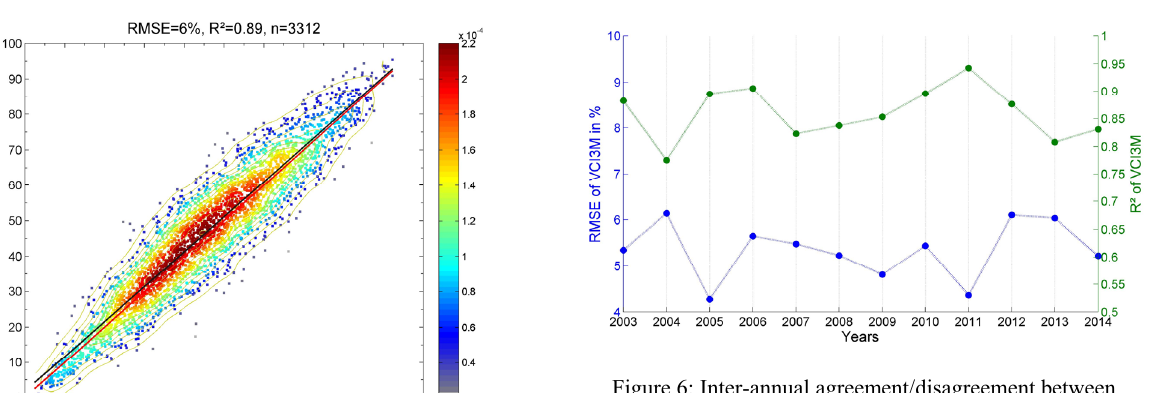
Figure 6: Inter-annual agreement/disagreement between monthly FEWS NET and BOKU VCI3M values. (green) coefficient of determination (R²), (blue) root mean square error (RMSE). Lines are only shown for reader's convenience Figure 4: Scatterplot of 3-monthly aggregated VCI (VCI3M) derived from FEWS NET and BOKU datasets of ASAL The spatial variation of RMSE for the ASAL counties is shown counties across all months between 2003 and 2014. 1-to-1 line (red) and regression line (black) and years of the two datasets. The resulting RMSE ranges The two seasons are captured by the average monthly NDVI counties (e.g. Turkana, Marsabit, Wajir) as well as southwestern profile derived from the weekly NDVI values between 2003 and 2012 for all ASAL pixels (orange line in Figure 5). Obviously, the largest differences in the VCI3M anomalies occur in parallel Figure 7, green and dark-green). to significant NDVI changes - these are periods of prime interest for image interpreters and NDMA.